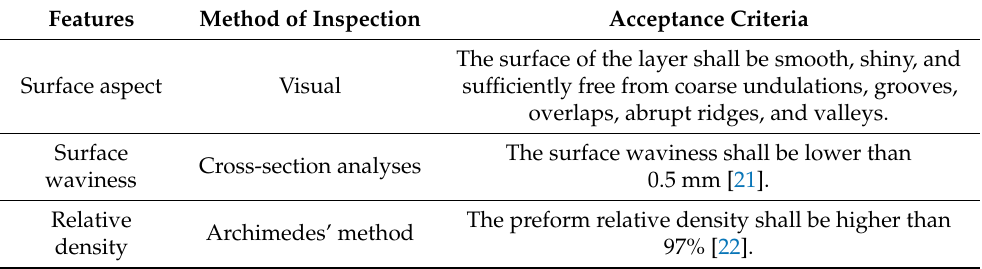
Table 4. Acceptance criteria for the work envelope.